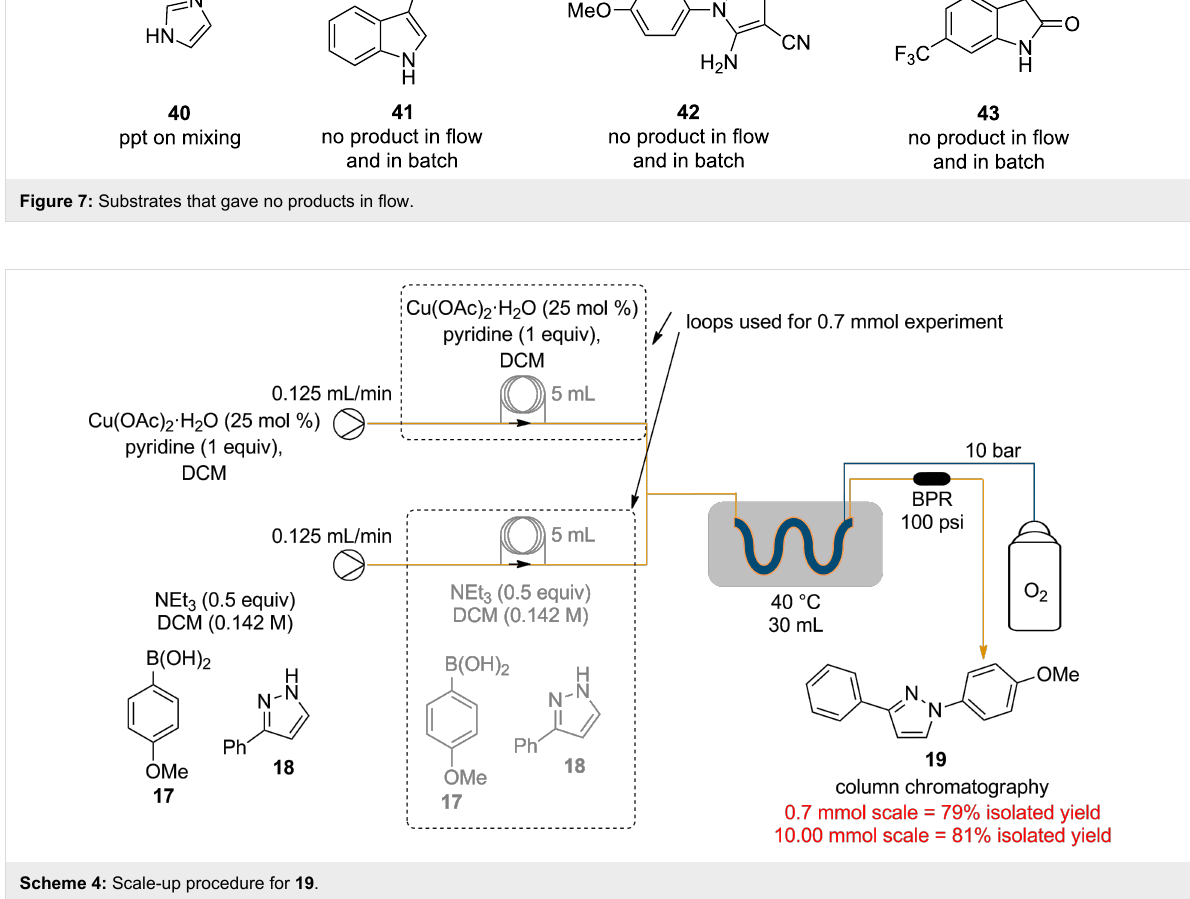
Scheme 4: Scale-up procedure for 19